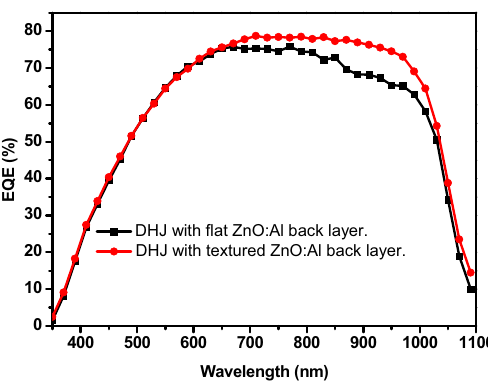
Fig. 6. EQE curves of DHJ with flat or textured back side ZnO:Al